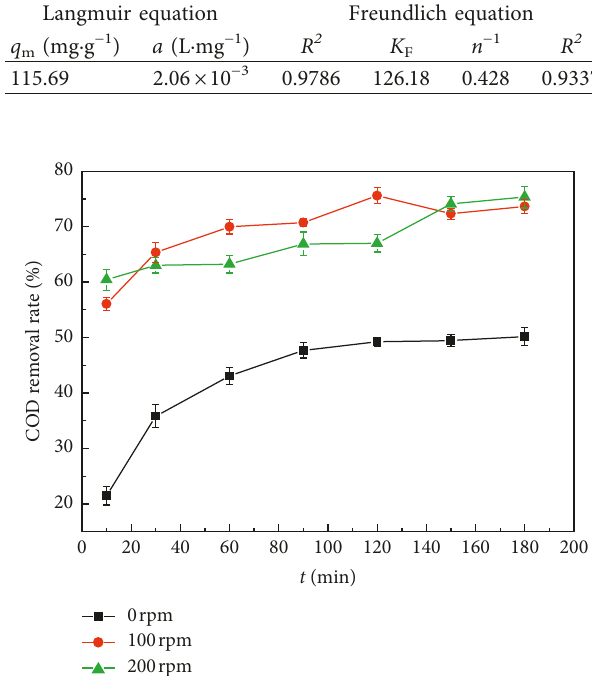
Figure 6: Effects of shaking speed on the COD removal rate (the error bars indicate standard deviation of the mean of three sets of